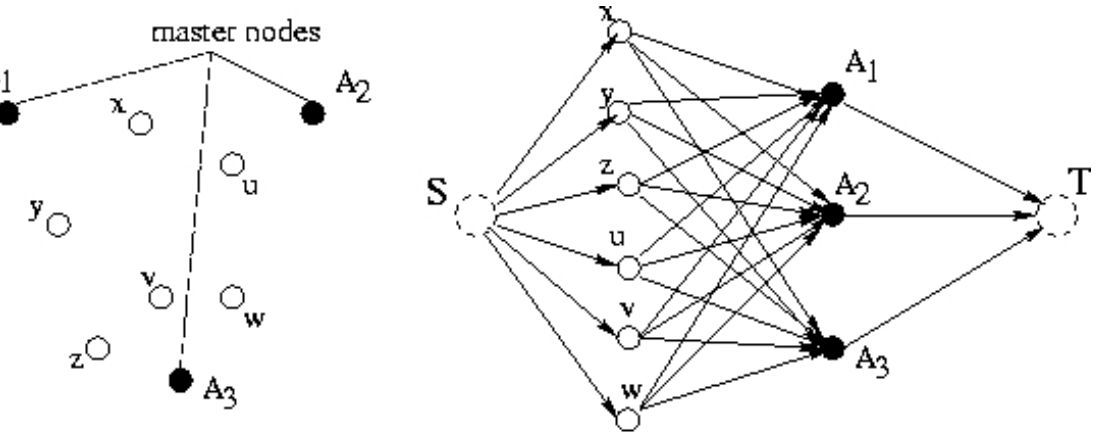
Figure 3. Transforming a balanced k -clustering instance to a minimum cost flow instance. Each sensor node has unit capacity, while each master nodes has capacity n/k